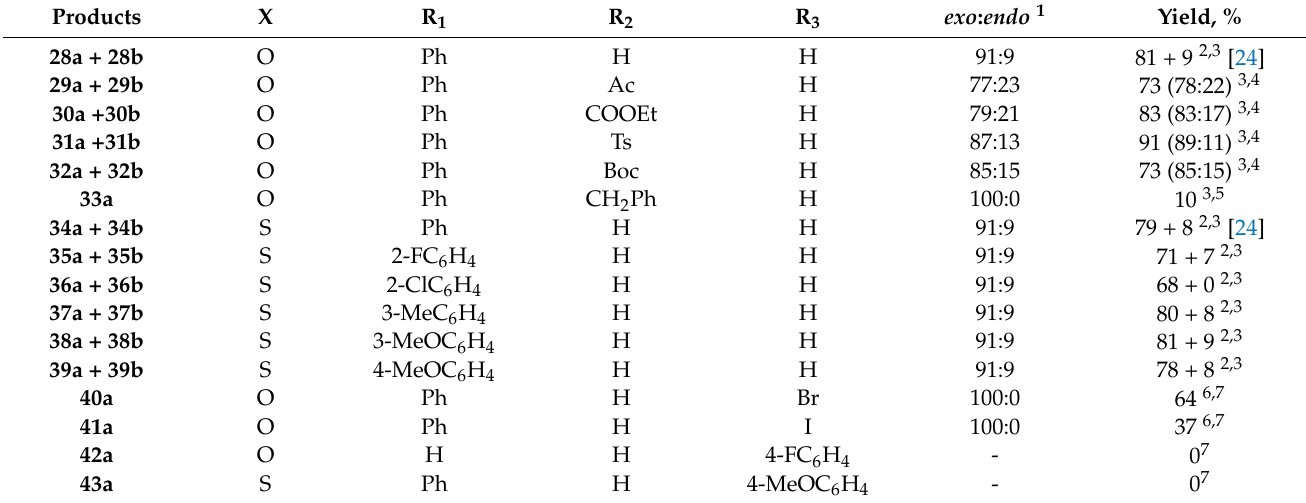
Table 1. Diels–Alder reactions of methylideneimidazolone derivatives with